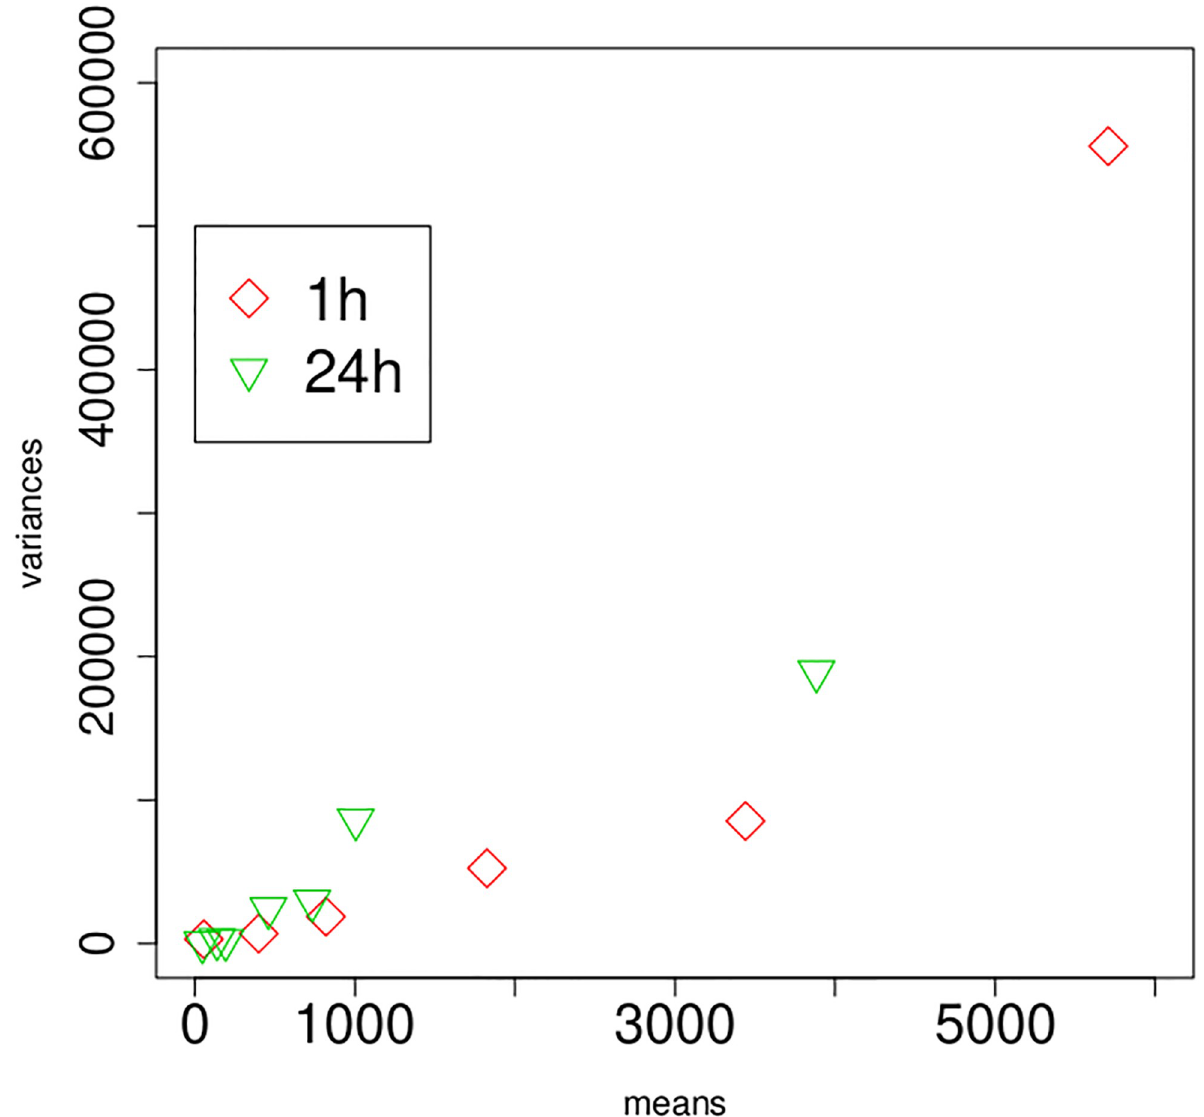
Fig 4. For each dose point, empirical variances vs means for the 1h and 24h data, plotted on the scale of absolute focus counts.